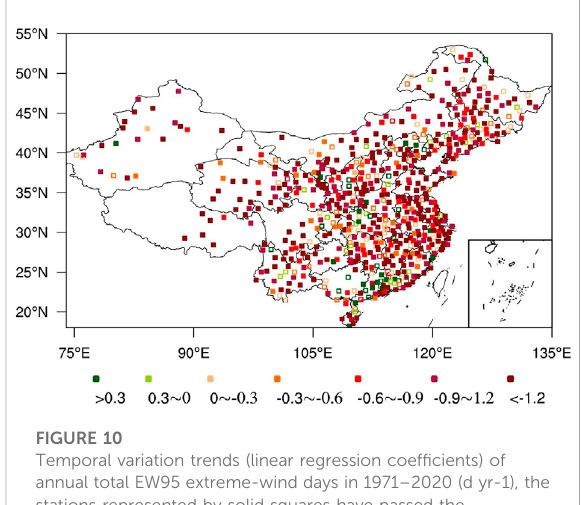
FIGURE 10 Temporal variation trends (linear regression coef fi cients) of annual total EW95 extreme-wind days in 1971 – 2020 (d yr-1), the stations represented by solid squares have passed the 0.01 signi fi cance